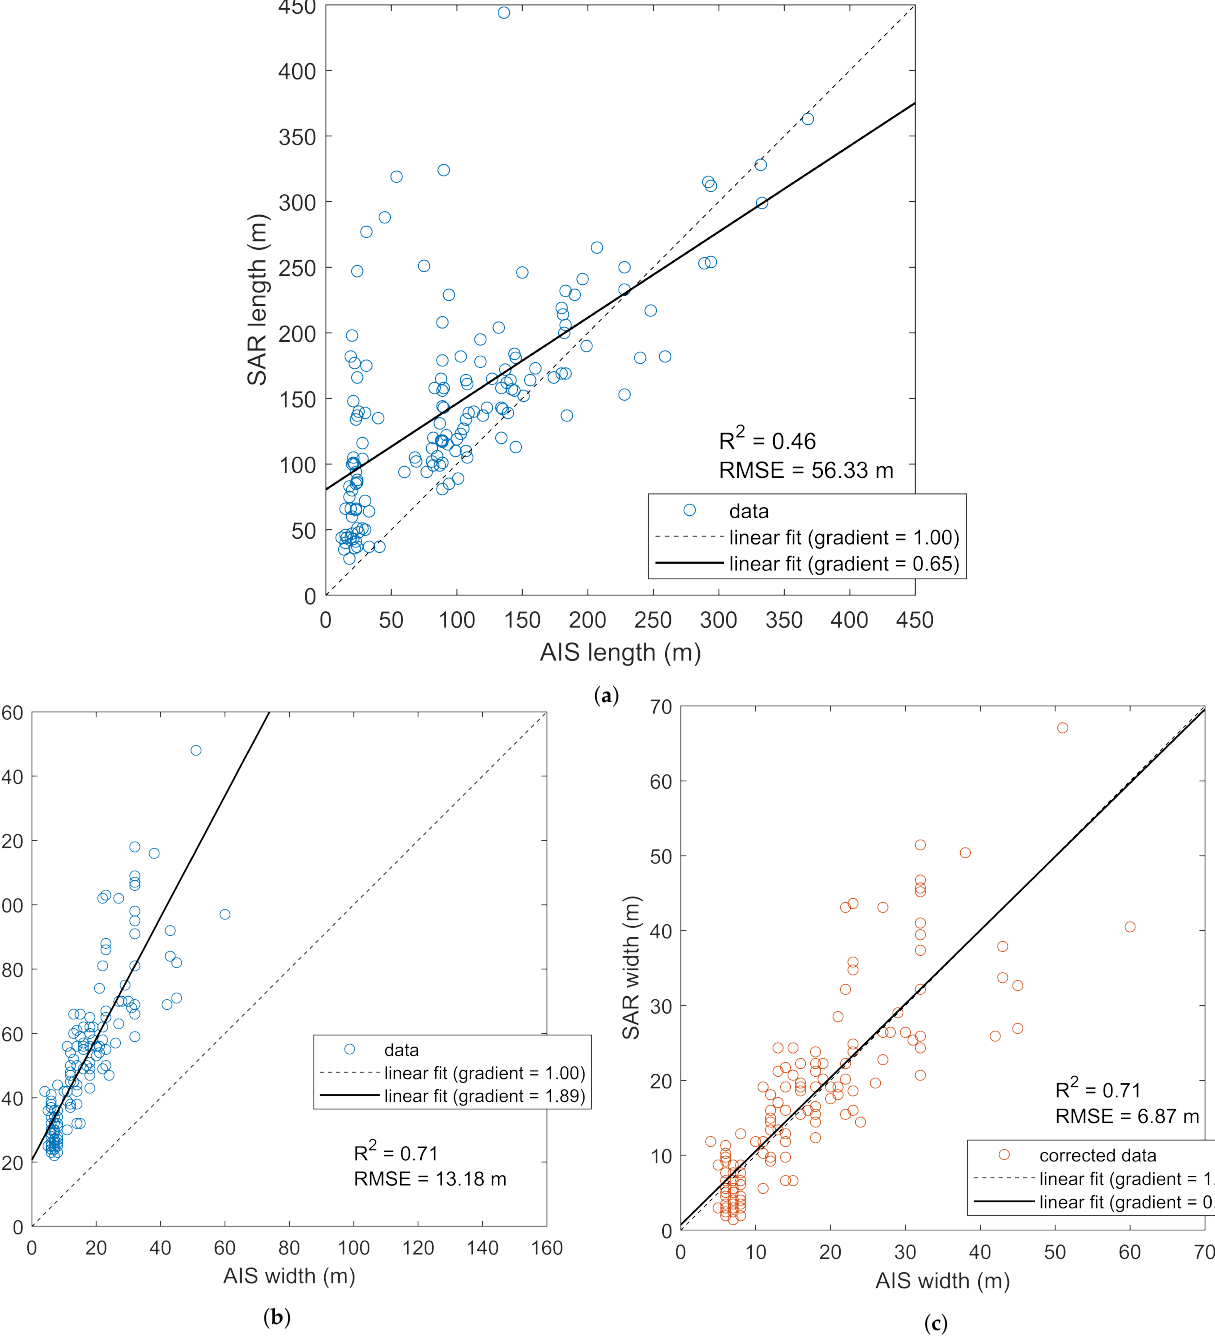
Figure 14. English Channel estimated SAR ( a ) length; ( b ) width; ( c ) updated width; against reported AIS for each